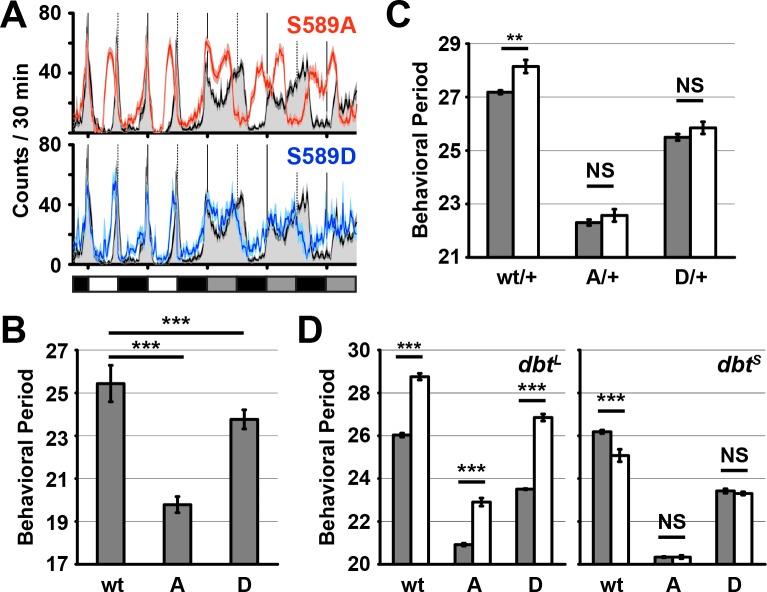
Residue substitutions of S589 differently affect behavioral rhythmicity.(A) Transgenic wild-type per (black line), S589A per (red line) or S589D per (blue line) were expressed in a per0 genetic background and monitored for behavior in a 12:12 light dark cycle followed by constant darkness and activity recorded and plotted. The solid vertical lines demark days, while the dotted vertical lines represent the light-to-dark transition point. White, black and grey boxes represent lights on, lights off and subjective day during lights off, respectively. N = 27–28. Each data point is the mean ± SEM. Thickness of the curve reflects SEM. (B) Flies described in panel A quantified for behavioral periodicity in constant darkness. wt: wild type, A: S589A, D: S589D. N = 25–27. Bars represent means ± SD. ***p<0.005. Significance was measured by an unpaired, two-tailed t-test. See Supplementary file 1 for values. (C) The behavioral period of heterozygous flies carrying the transgenic per variant (as indicated) in the absence of DBT overexpression (grey bars, per0; attP40{per} / +; UAS-dbt) or with DBT overexpression in clock neurons (white bars, per0; attP40{per}/tim-UAS-Gal4; UAS-dbt) were quantified and plotted. N = 19. Bars represent means ± SD. **p<0.01. NS, not statistically significant. Significance was measured by t-test. See Supplementary file 1 for values. (D) The behavioral period of per transgenic flies in a dbtL or dbtS genetic background (white bars) or wild type dbt background (grey bars) were quantified and plotted. N = 8–24. Bars represent means ± SD. ***p<0.005. NS, not statistically significant. Significance was measured by t-test. See Supplementary file 1 for values.